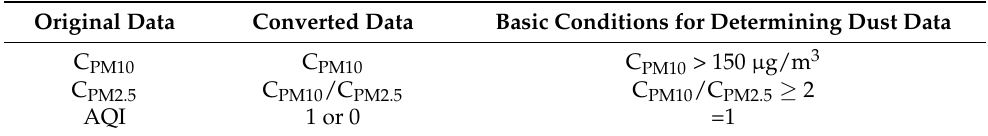
Table 1. Index setting of sand dust data feature